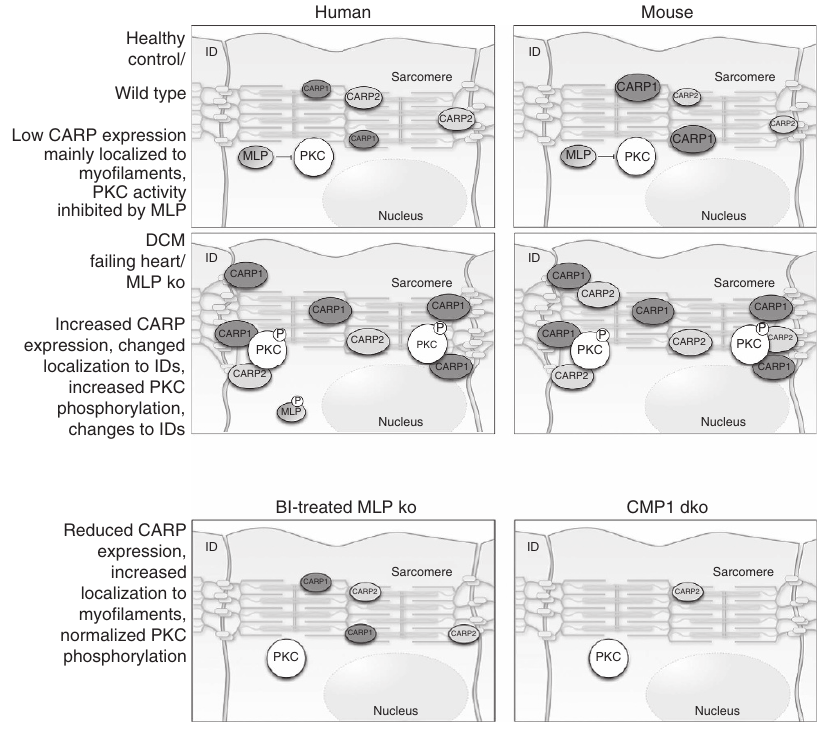
Figure 5 | Model of signalling processes in functionally healthy and failing hearts. Schematic presentation of CARP1, CARP2, MLP and PKC a localizations, phosphorylation states and protein amounts (size of symbol) in the patient groups and analysed mouse